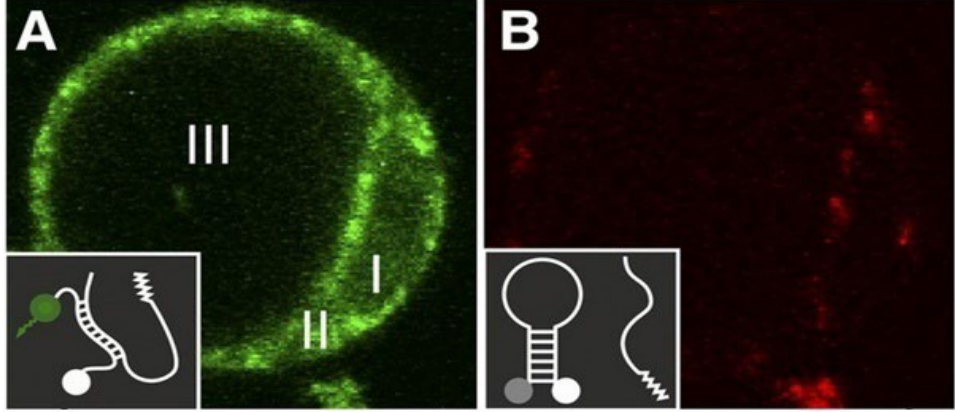
Figure 6. In vivo RNA imaging of Arabidopsis protoplast. Sequence-specific molecular beacons ( A ) and control ones ( B ) were electroporated into the protoplast; I, nuclear region; II, cytoplasm; III, vacuole. Reprinted with permission from [88].